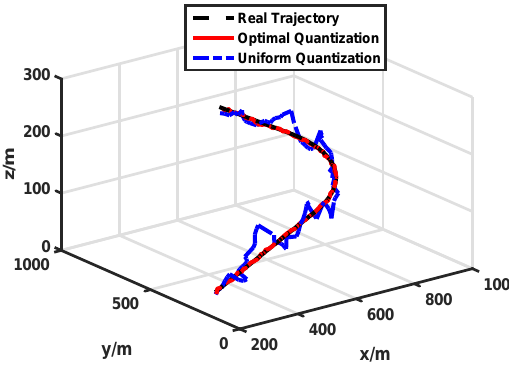
Figure 3. Target tracking performance with 1-bit quantized measurements.